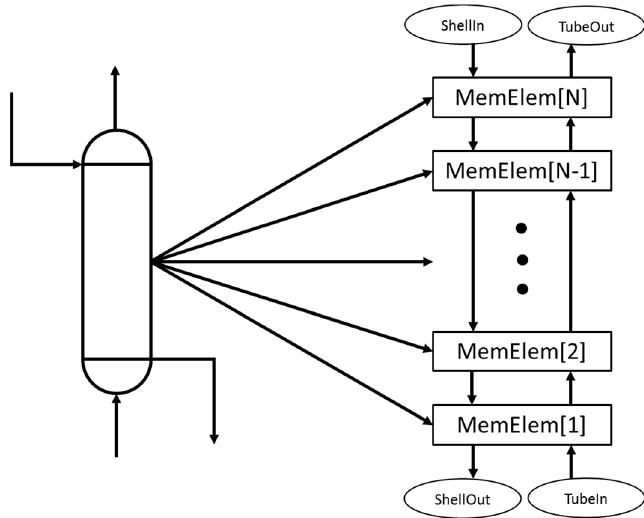
Figure 2. The submodel structure for the MemElem model.